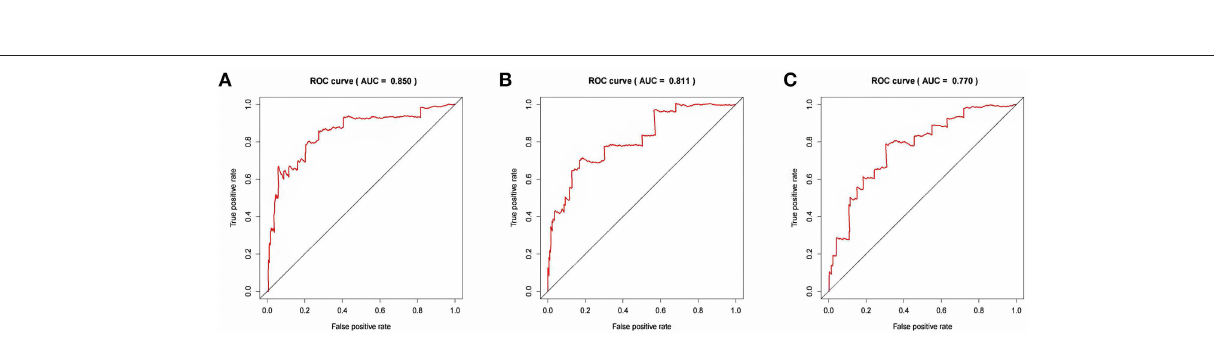
FIGURE 5 | Predictive model for colorectal cancer patients. Overall survival curves according to lncRNA-based model (A) , the miRNA-based model (B) , and the mRNA-based model (C) of colon cancer patients with low or high risk.